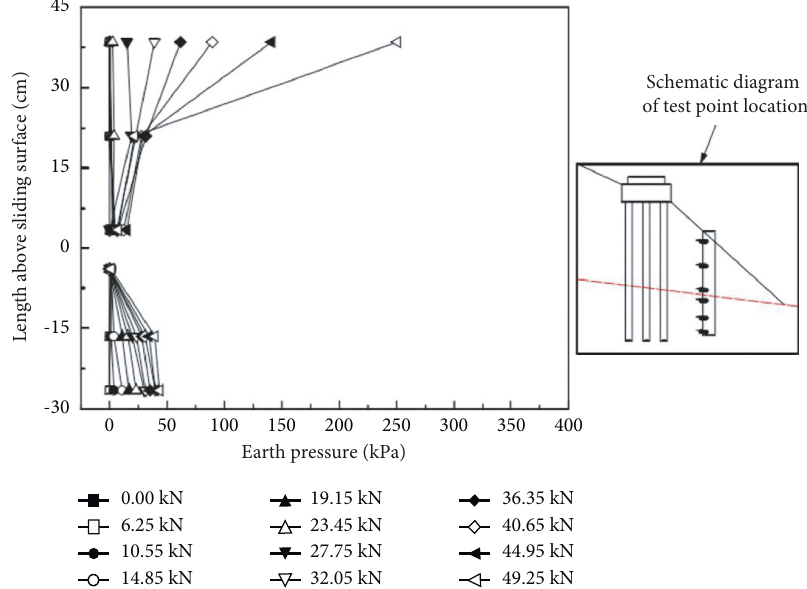
Figure 22: Relationship between soil pressure distribution and load behind front antislide